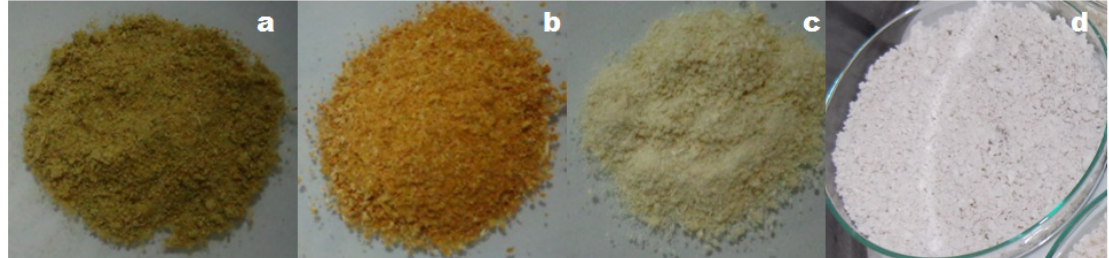
Figure 1. Technological processing of Opuntia ficus-indica L. Miller for cellulose extraction. ( a ) powdered plant, ( b ) powdered plant free of impurities, ( c ) holocellulose and ( d ) cellulose.